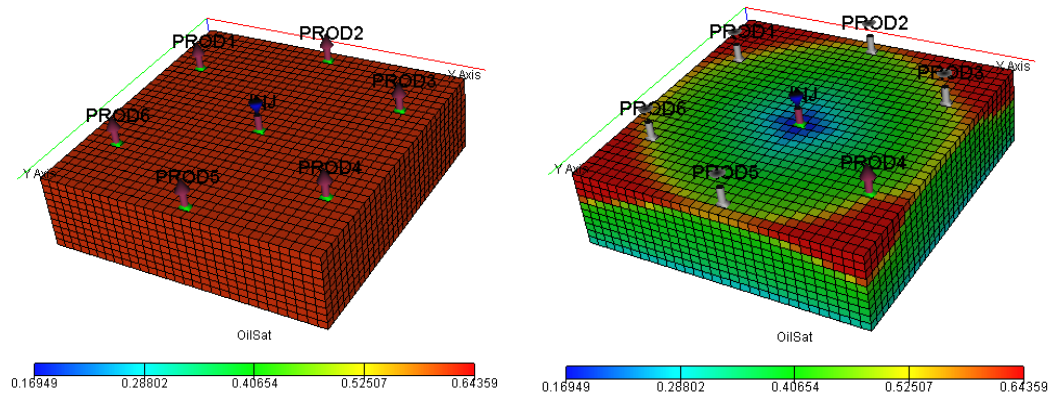
Figure 26. Field oil production rate and field water production rate against time.